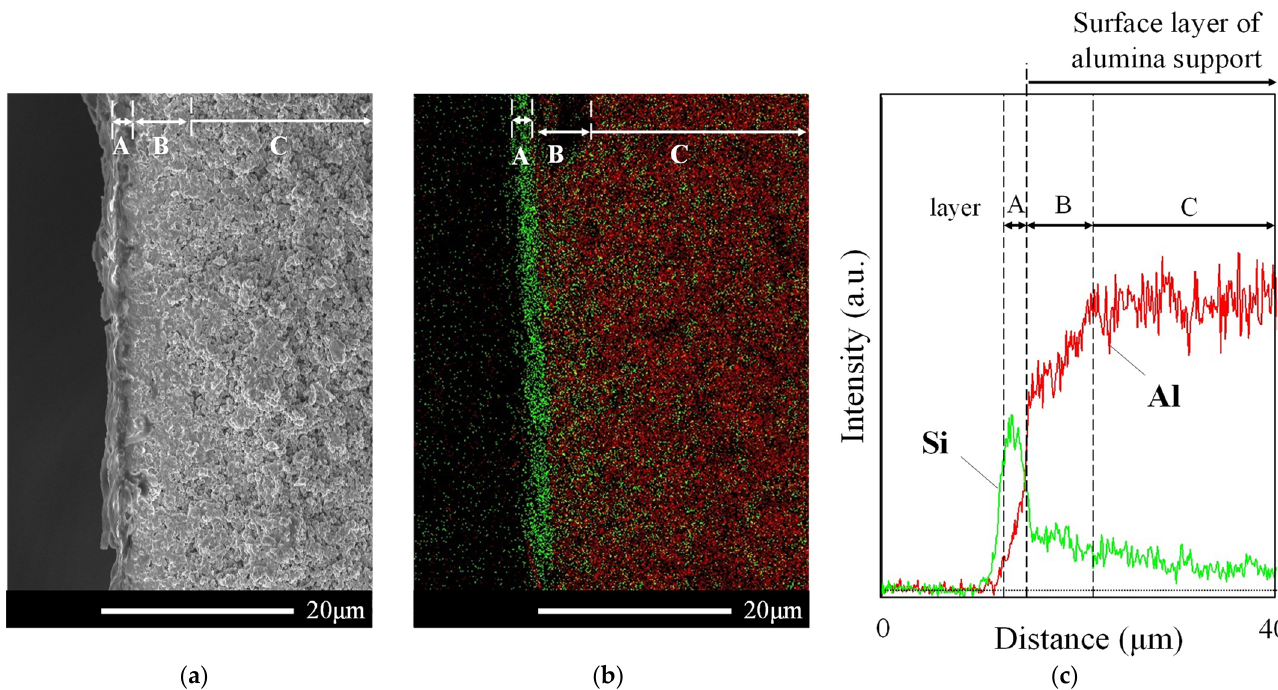
Figure 9. SEM image ( a ), element mapping ( b ), and line analysis ( c ) of the cross-section of the Al-containing ZSM-58 membrane (M4). Si and Al are indicated by green and red, respectively .